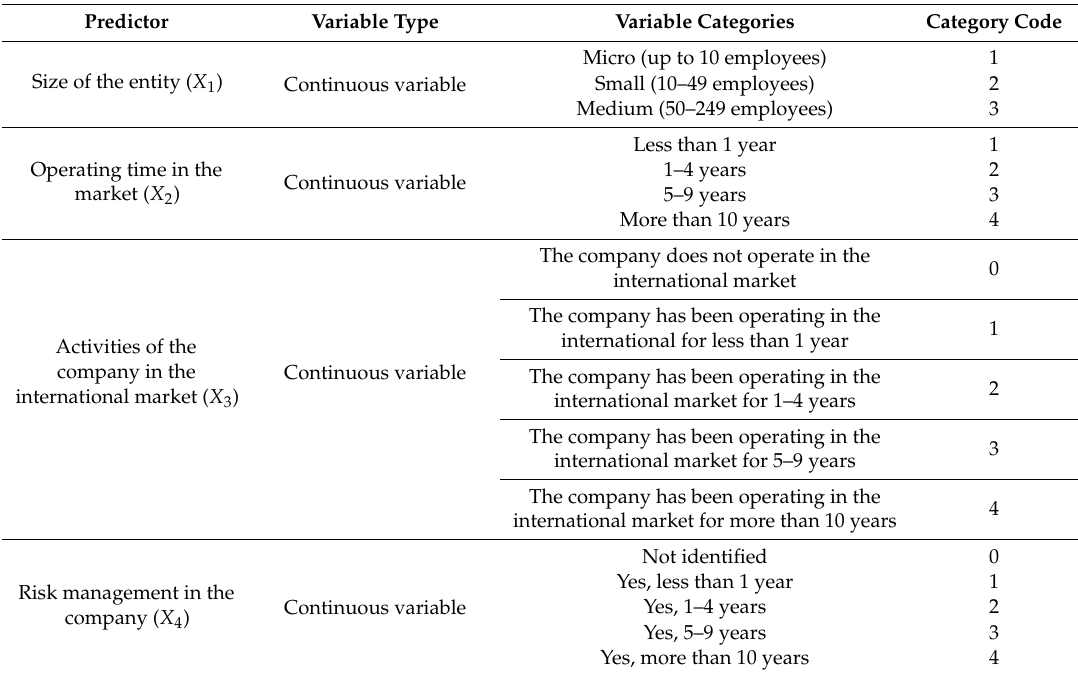
Table 2. The characteristics of independent variables in the